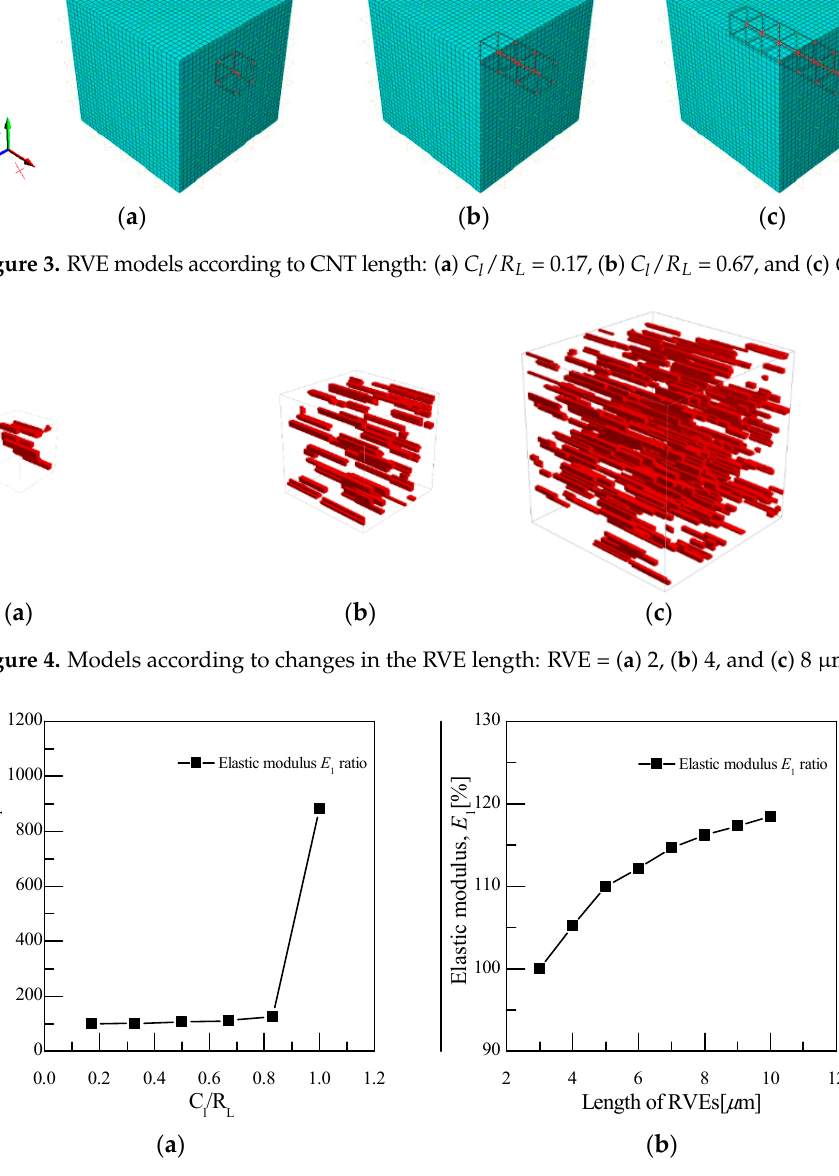
Figure 5. Changes in the effective properties according to changes in the CNT and RVE lengths: ( a ) variation in the effective properties according to C l / R L ; ( b ) variation in the effective properties according to the RVE length.